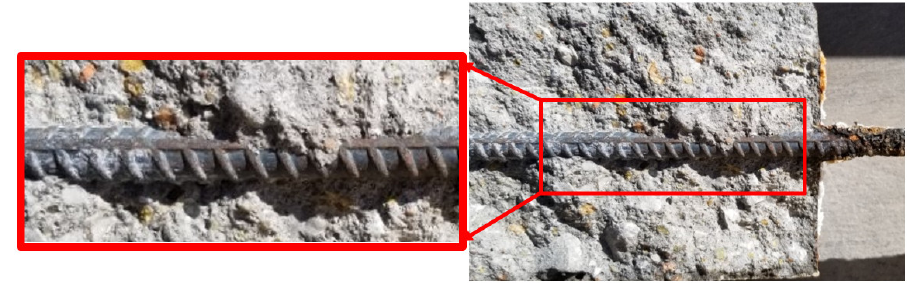
Figure 9. Specimen B—Progression of the UGWL readings from three points over time.